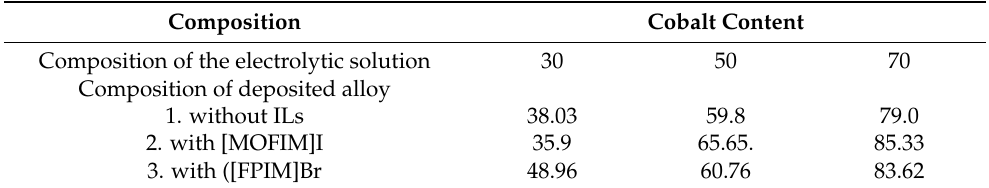
Table 2. The content of Co 2+ in the electrolytic solution (wt.%) and the cobalt content (at.%) in the deposited Ni-Co alloys without and with additives.